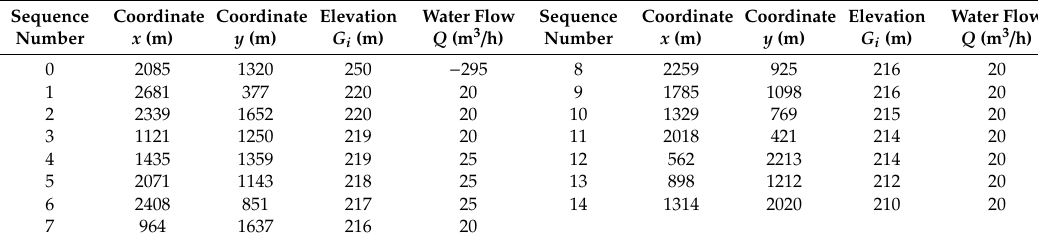
Table 4. Pipe network parameters (15 nodes).